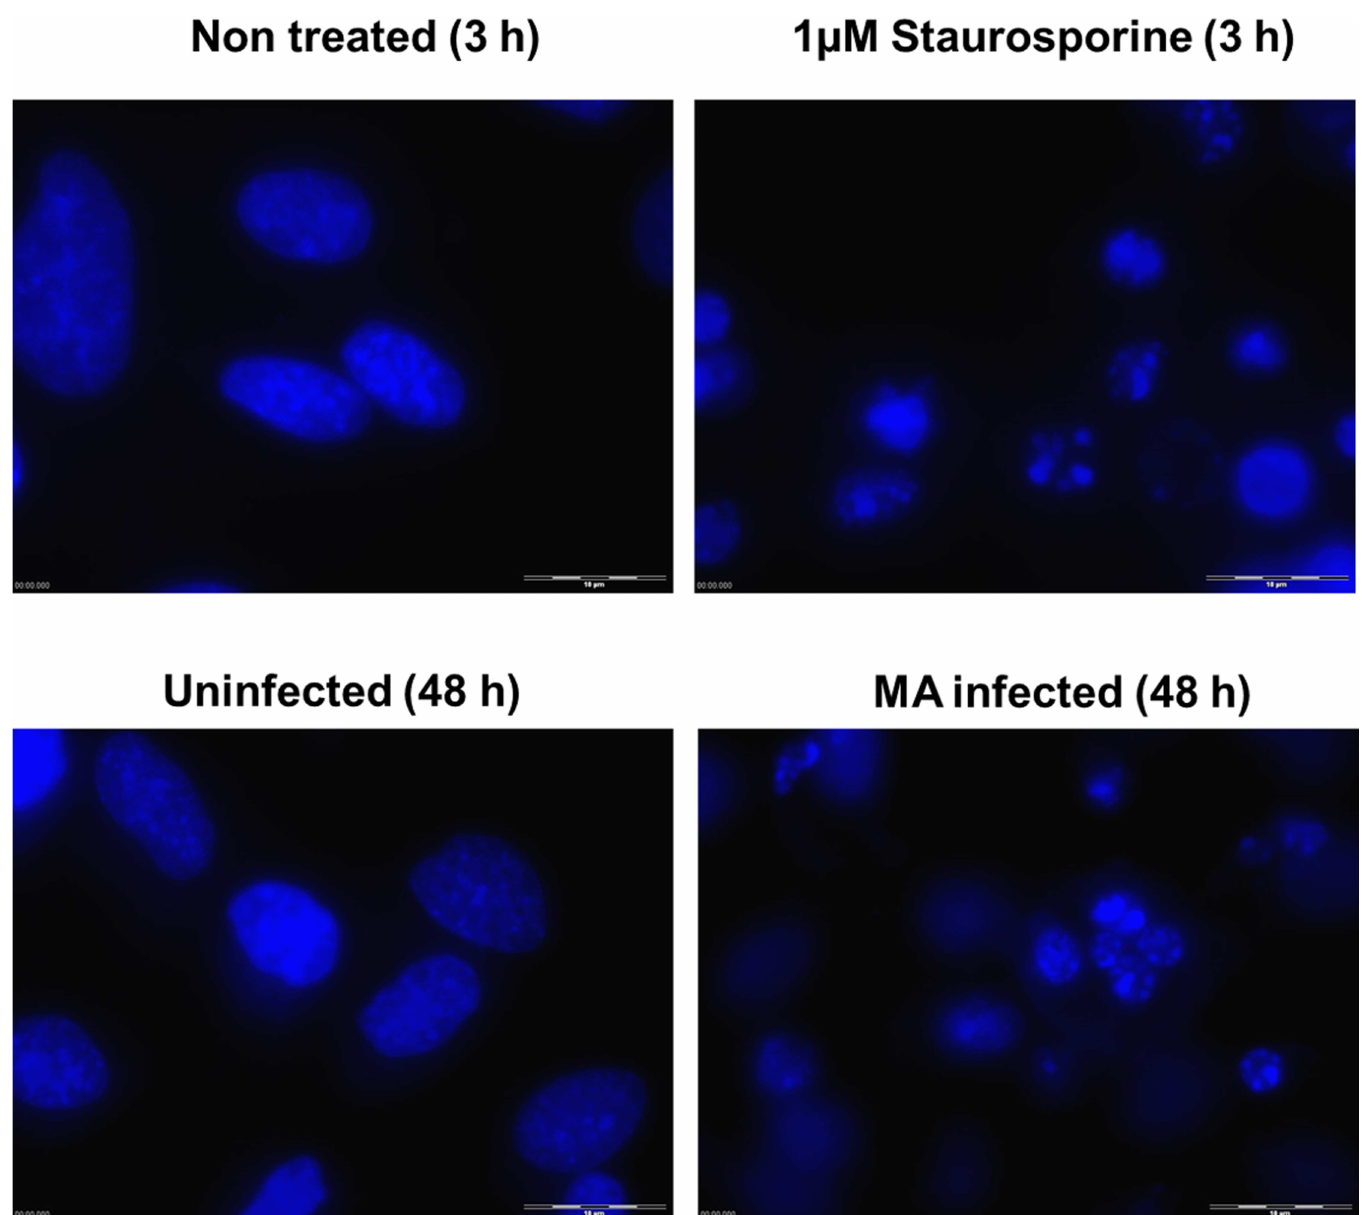
Fig 3. DNA fluorescence staining showing chromatin condensation in M . agalactiae -infected HeLa cells 48 h p.i. Cells were permeabilized and stained with DAPI, and images were taken using a fluorescence microscope. As a positive control, HeLa cells were treated with 1 μ M staurosporine for 3 h and stained with DAPI. Bars, 10 μ